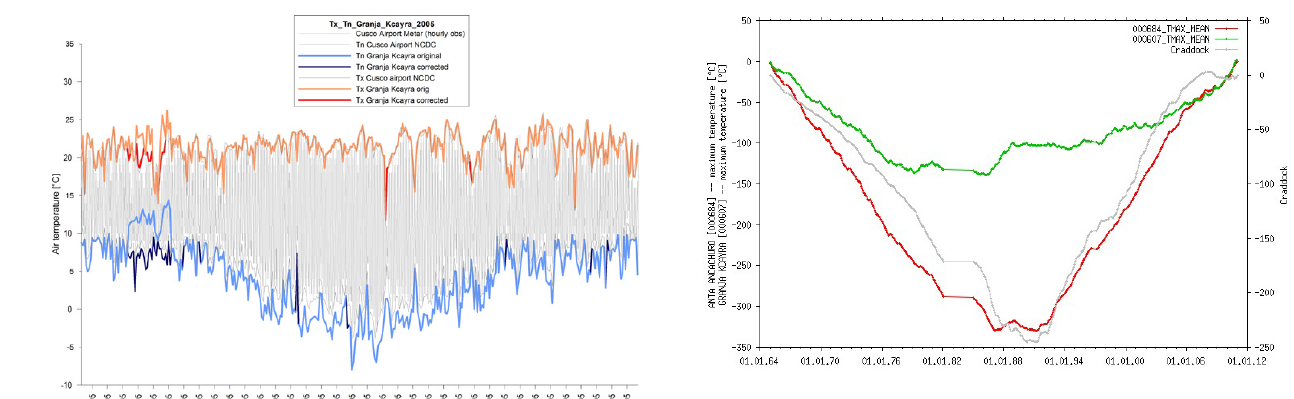
Figure 9. The craddock test (Craddock, 1979), as available in the PACC data portal shows a strong inhomogeneity in the Anta Ancachura-Granja Kcayra relation of monthly mean maximum